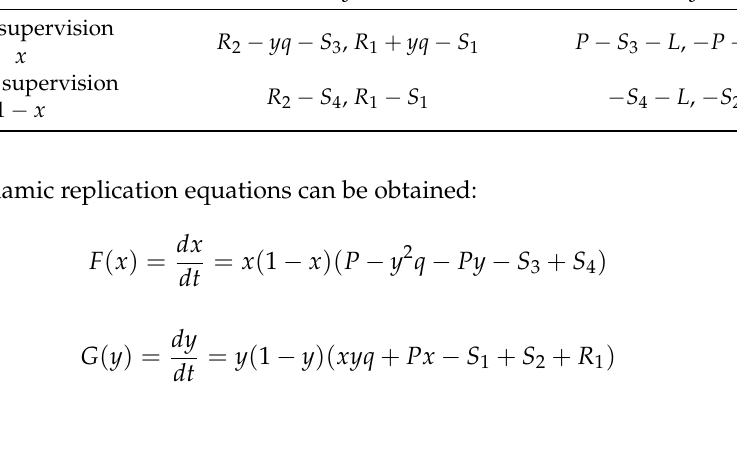
Table 5. The game payment matrix under dynamic reward and static punishment.